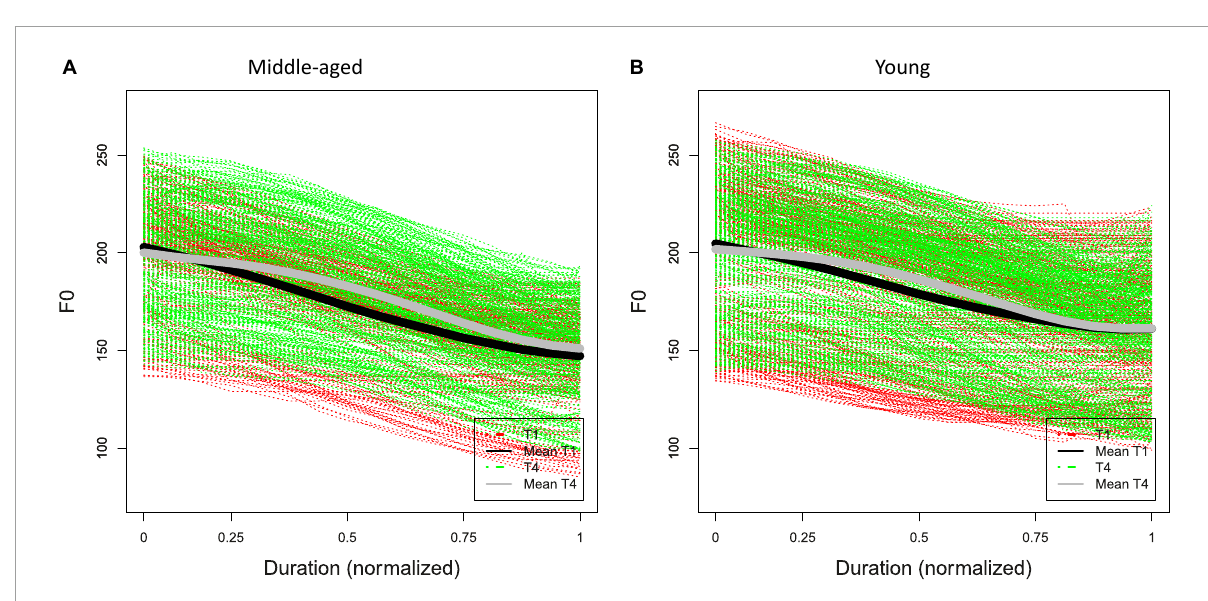
FIGURE3 Time-normalized raw F0 contours of T1 and T4 of (A) 30 middle-aged participants and (B) 30 young